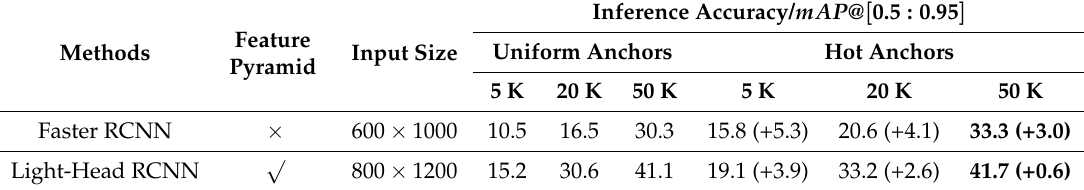
Table 1. The Inference Accuracy in Faster Region Convolutional Neural Network (RCNN) and Light Head RCNN. 1 K equals to 1000.